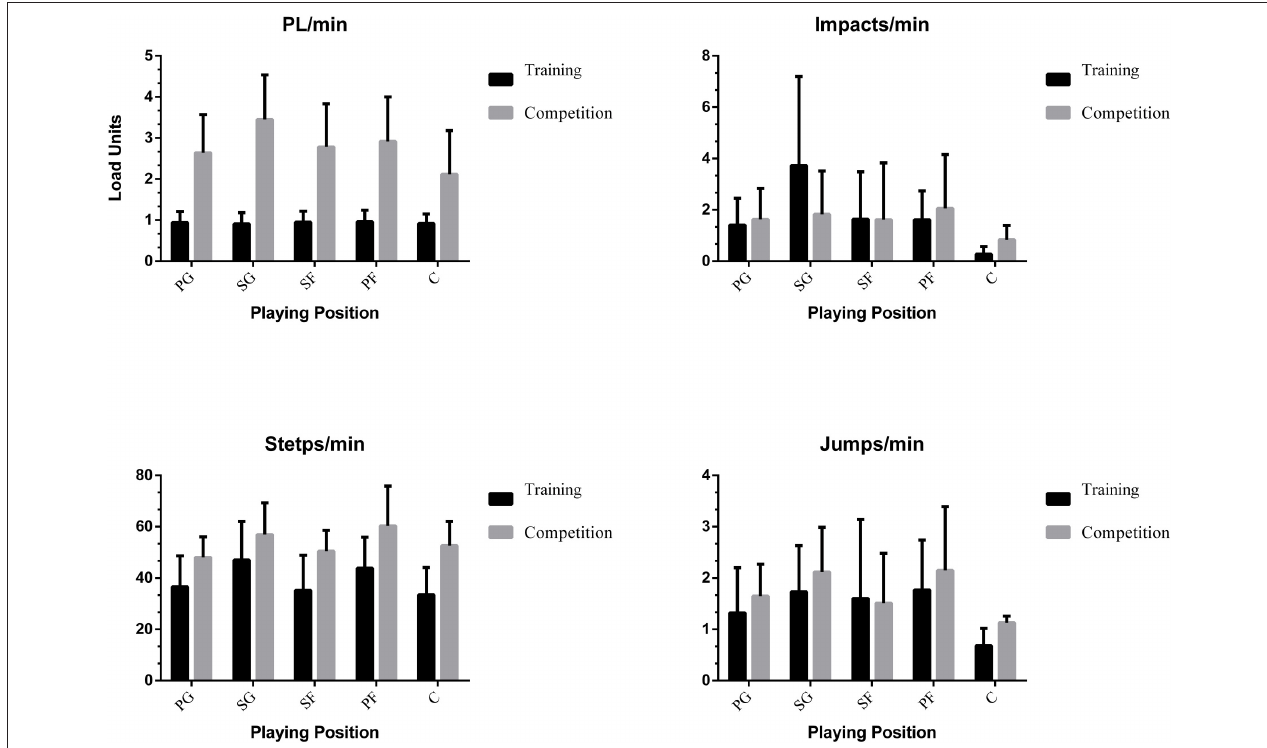
FIGURE 6 | External load by playing